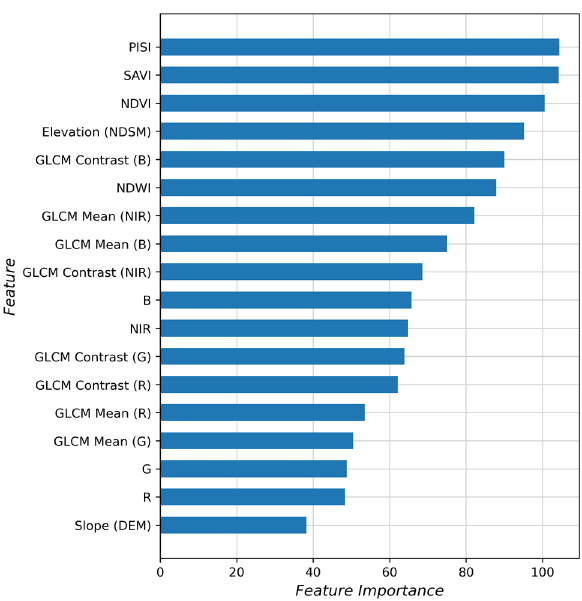
Figure 8. The feature importance of the RF classi fi er calculated in GEE.